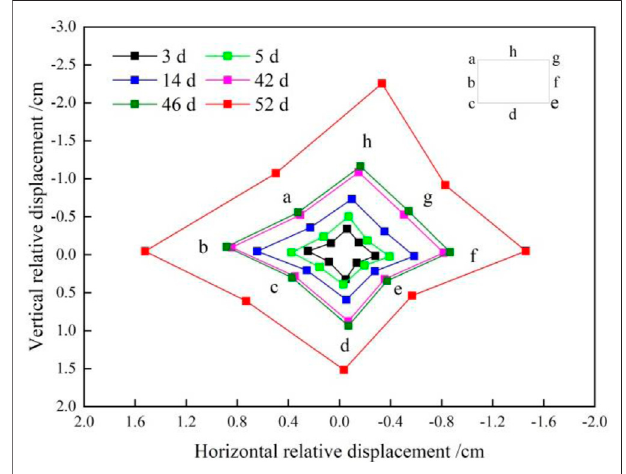
times in the dry